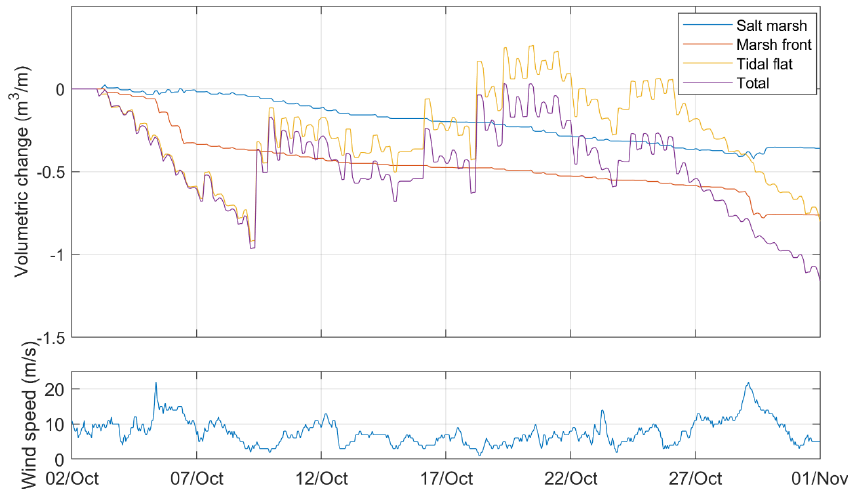
Figure 7. Simulated width averaged volumetric change ( m 3 / m ) over time within the study area (top) and the wind speeds during the simulation period (m/s) (bottom). The storms are during 4–5 October and 28–29 October. A relatively calm period is simulated from 9 to 22 October.